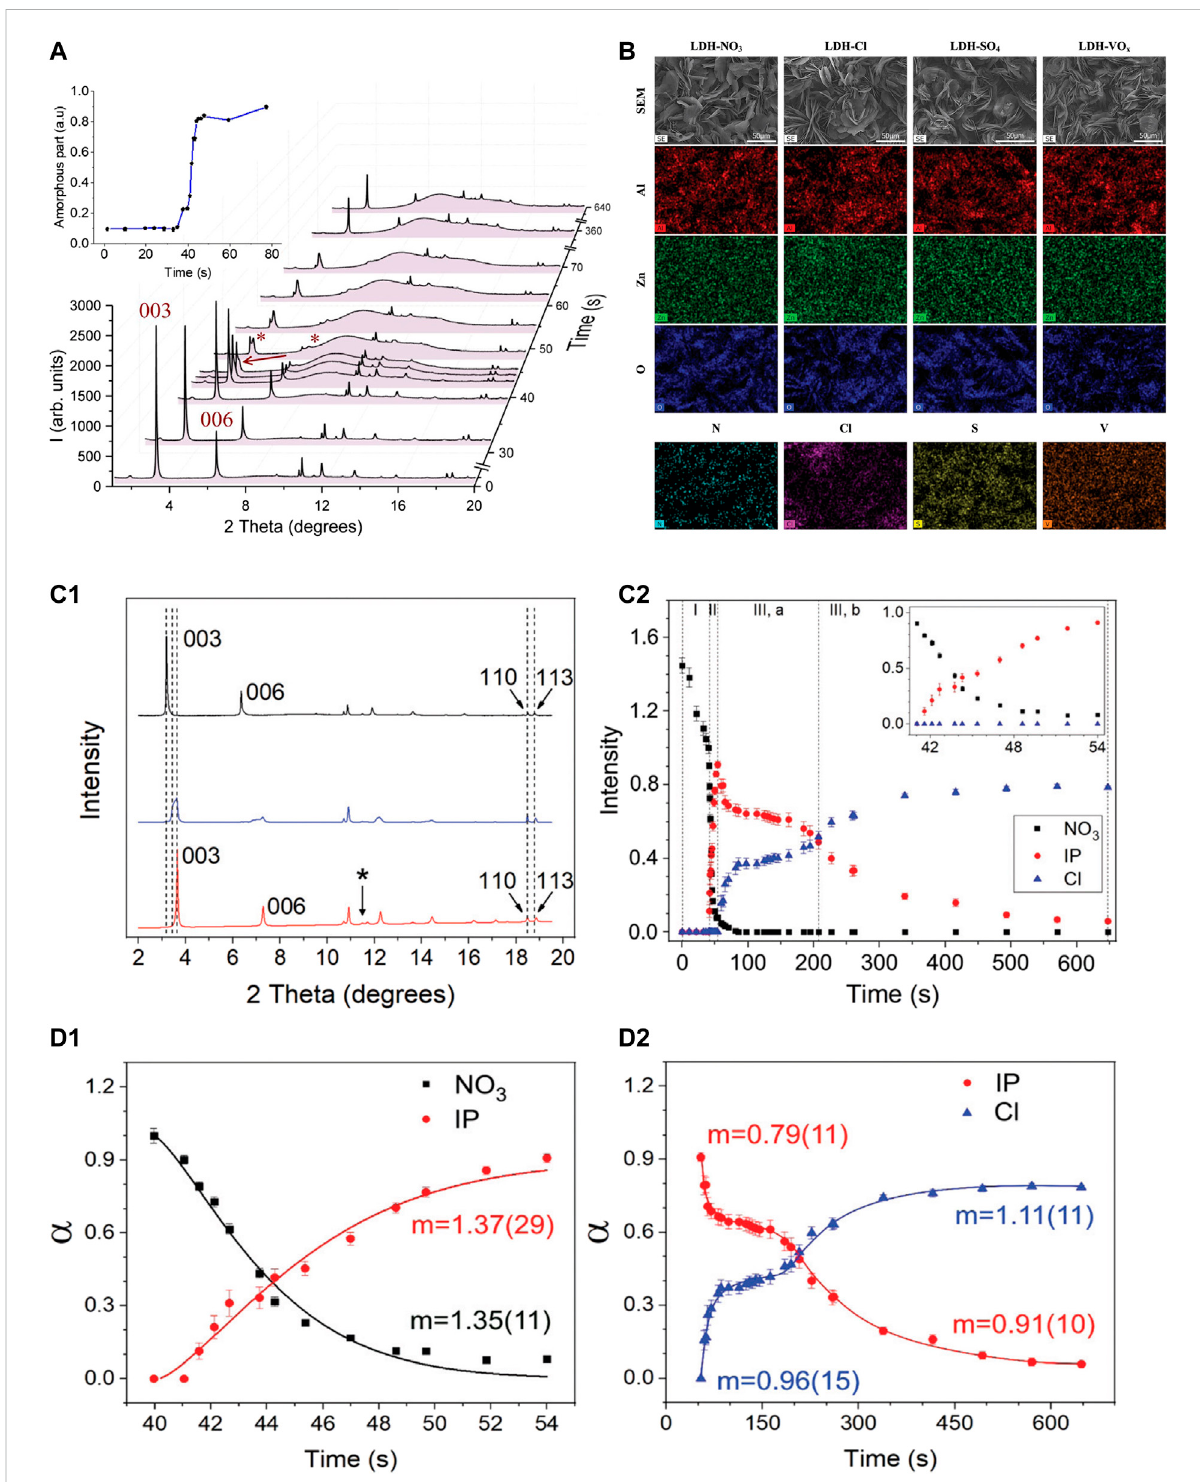
FIGURE 7 XRD patterns (A) for Cl − intercalation process on Zn coated with LDH (Bouali et al., 2020a); SEM-images and EDS maps (B) of LDHs with NO 3 − , Cl − ,SO 4 2- ,VO x y − ; (C1) XRDpatternsofinitialLDH-NO 3 (black),stateofcoexistenceofinitialand fi nalphases(blue)and fi nalLDH-Cl(red)phases; (C2) time evolution of the integral intensity of 003 peaks of the initial (LDH-NO 3 , squares), intermediate (IP, circles) and fi nal (LDH-Cl, triangles) phases; Kinetic dependences of the degree of substitution of NO 3 − by Cl − in Zn-LDH: (D1) interval II: release of NO 3 − (black squares), IP formation (red circles); (D2) interval III: IP decrease and formation of the fi nal crystalline phase with Cl-intercalated (blue triangles). Solid lines are the fi ttings of the AE model. Reproduced from (Iuzviuk et al., 2020) with permission from the Royal Society of